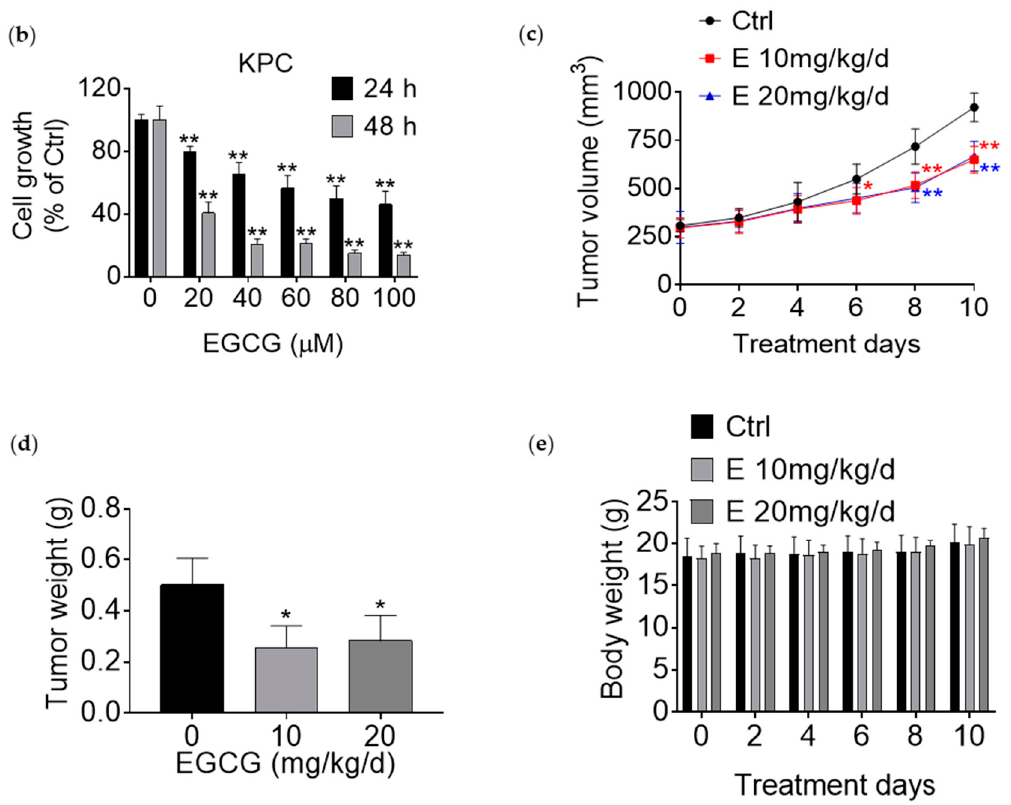
Figure 1. Epigallocatechin-3-gallate (EGCG) reduces pancreatic cancer cell growth in vitro and in vivo. ( a ) EGCG inhibits human pancreatic cancer cell growth in a concentration- and time-dependent manner. Cell growth was determined in Panc-1, MIA PaCa-2, HPAF-II, BxPC-3, SU- 86.86, CFPAC-1, and KPC pancreatic cancer cells, and in the human pancreatic normal epithelial (HPNE) cells after